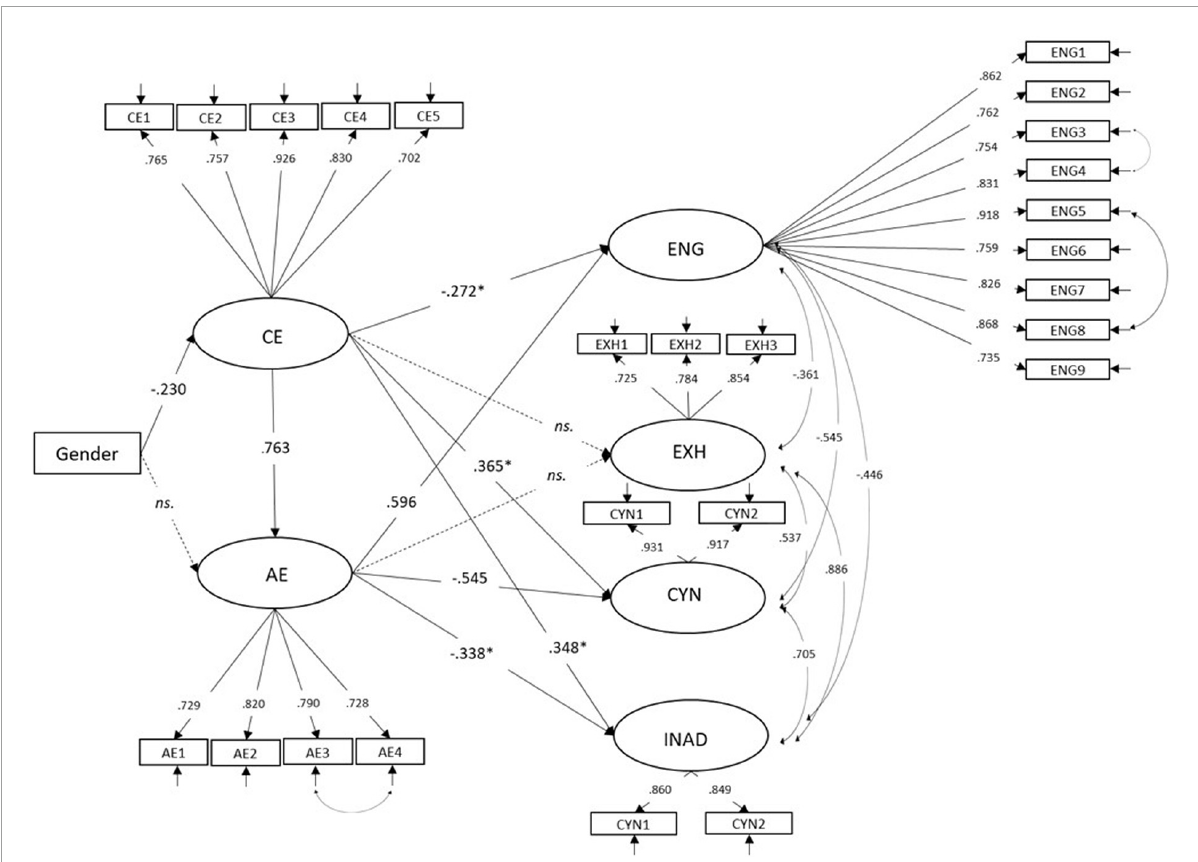
FIGURE2 The structural equation model of the relations between latent variables of cognitive empathy (CE), affective empathy (AE), study engagement (ENG), emotional exhaustion (EXH), cynicism (CYN), and inadequacy (INAD). Standardized model. ns. , indicates non-significant paths, * p < 0.05, all other parameters are significant at the p < 0.001